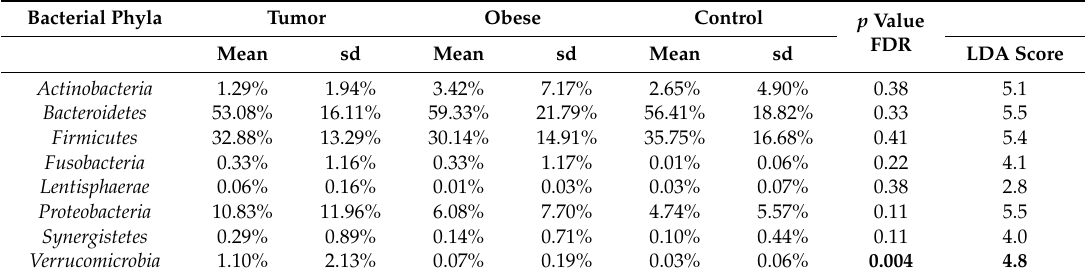
Table 3. Specific phyla. Linear discriminative analysis (LDA) e ff ect size (LEfSe) test showing the phyla associated with the three groups (Tumor, Obese, Control). Positive values of LDA scores (log 10) are indicative for enriched taxa in a given group. Significant p values are highlighted in bold. Abbreviations: sd = standard deviation; FDR = false discovery